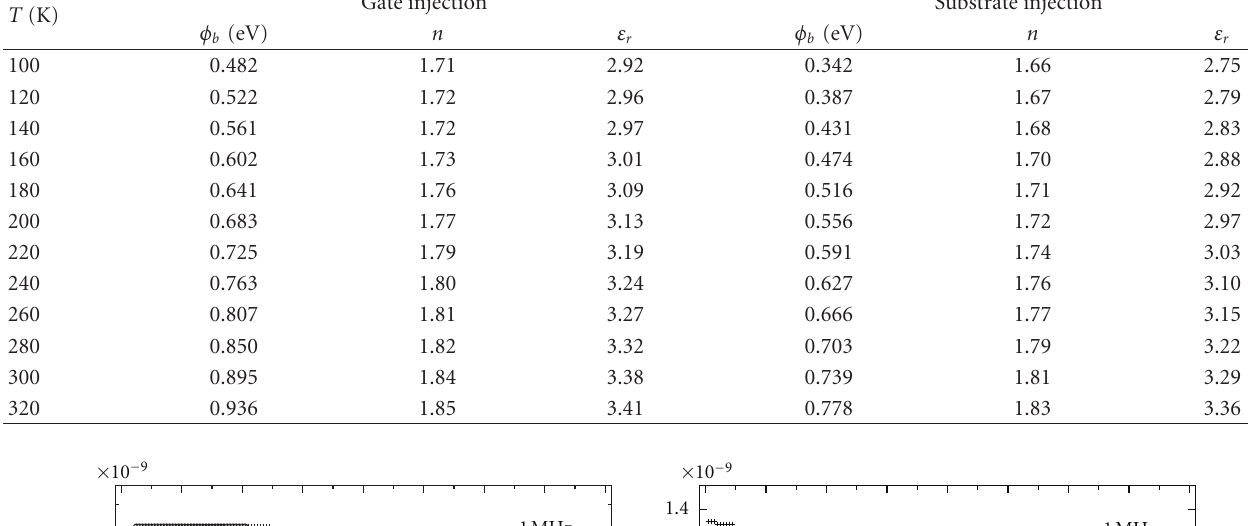
Table 2: Temperature-dependent values of various parameters obtained from the J-V characteristics of the Al/HfO 2 /p-Si structure. T (K)